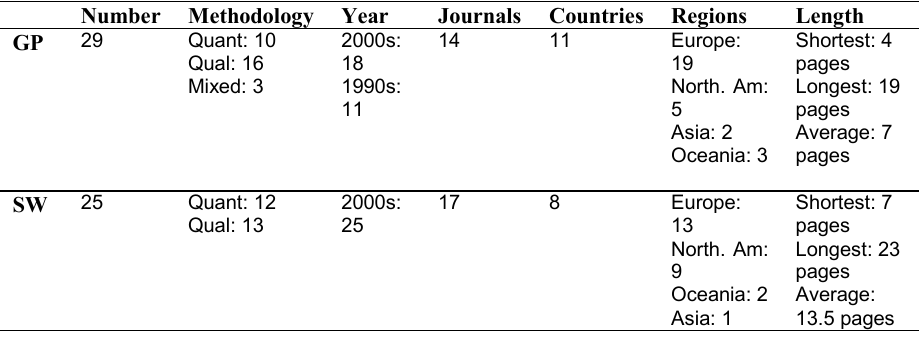
Table 1 Number and type of journals used in the